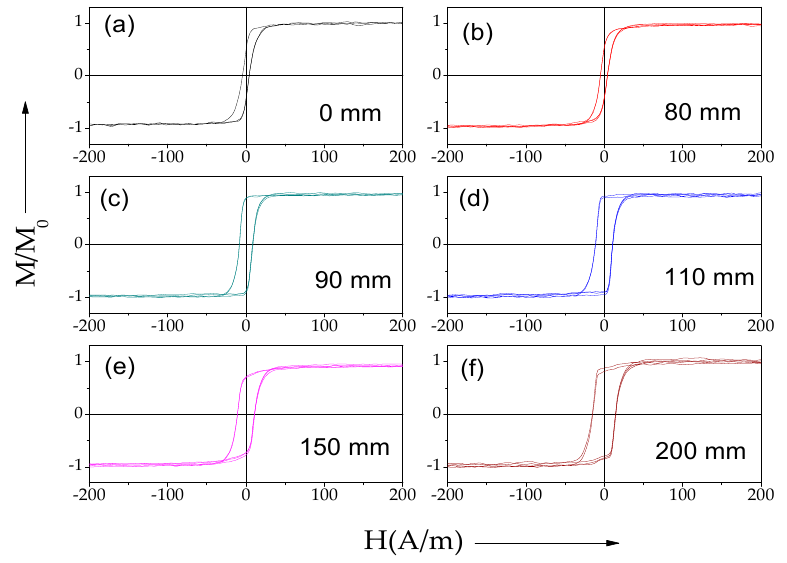
Figure 6. Hysteresis loops of sample 2 stress-annealed variable T ann and σ ≈ 400 MPa. T ann evaluated from Figure 3 are: 25 °C ( a ); 160 °C ( b ); 251 °C ( c ); 290 °C ( d ); 295 °C ( e ); and 300 °C ( f ), respectively.